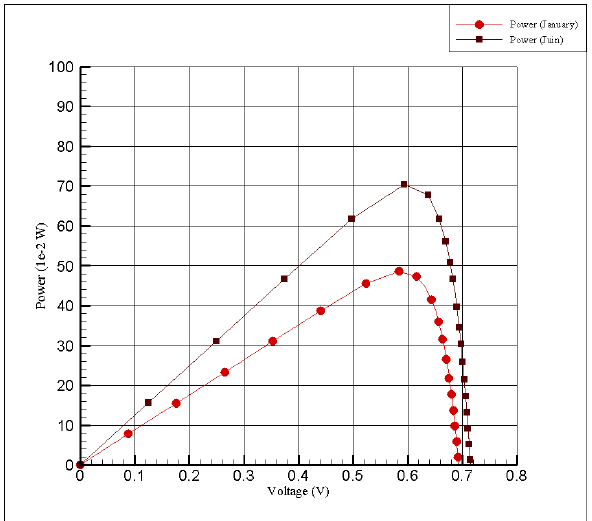
Figure 10. Open-circuit voltage and power testing graphs in January and June.